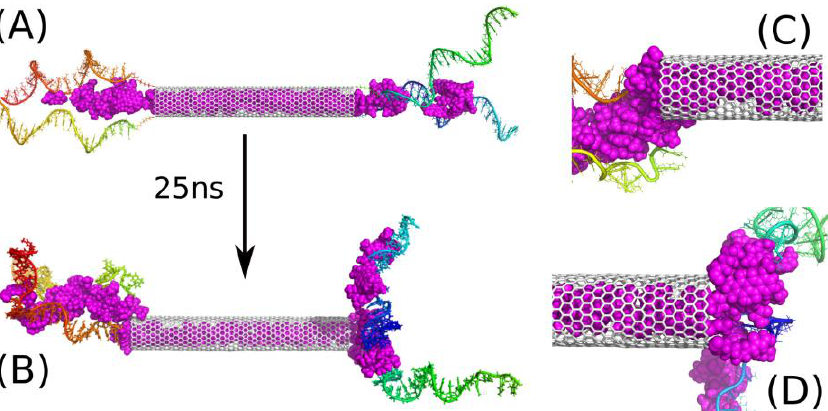
Figure 4. ( A ) Initial state of E2D40 system, i.e., with additional 20 DOX (magenta) molecules placed initially in the space between iM chains and with only two iM chains in each side; ( B ) the state of E2D40 system after 25 ns of simulations. ( C , D ) show zoomed-in areas around CNT tips.